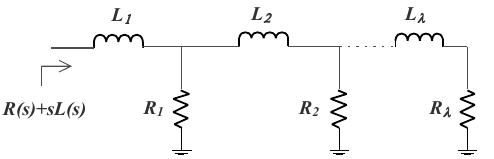
Fig. 1. Circuit configurations to model the frequency- dependency of R(s) + L(s)